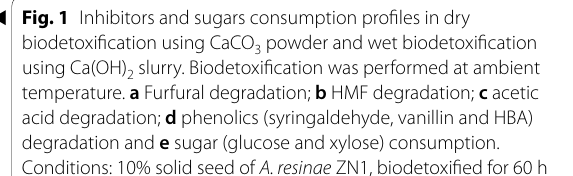
Fig. 1 Inhibitors and sugars consumption profiles in dry biodetoxification using CaCO 3 powder and wet biodetoxification using Ca(OH) 2 slurry. Biodetoxification was performed at